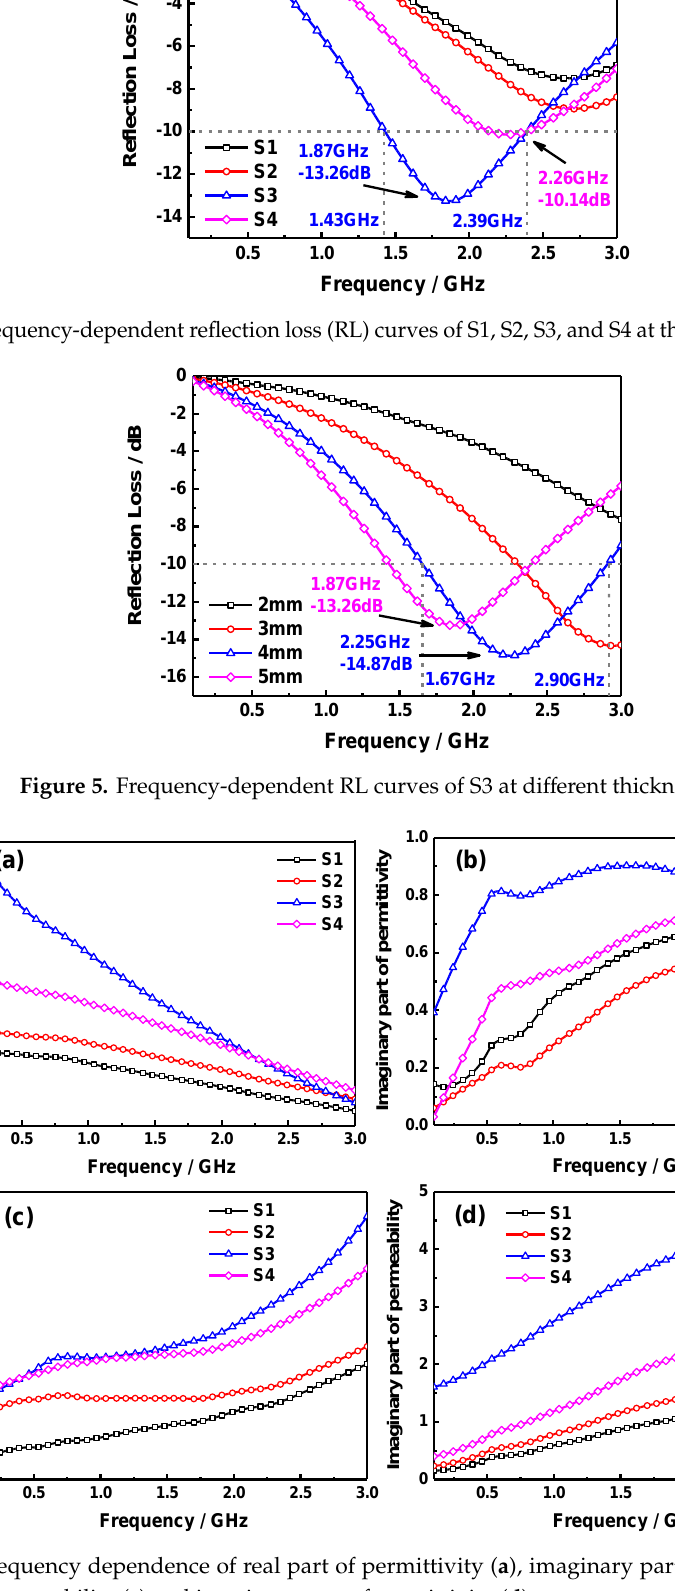
Figure 6. Frequency dependence of real part of permittivity ( a ), imaginary part of permittivity ( b ), real part of permeability ( c ) and imaginary part of permittivity ( d ).